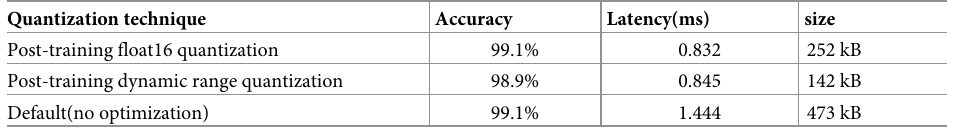
Table 4. Effect of different quantization techniques on model